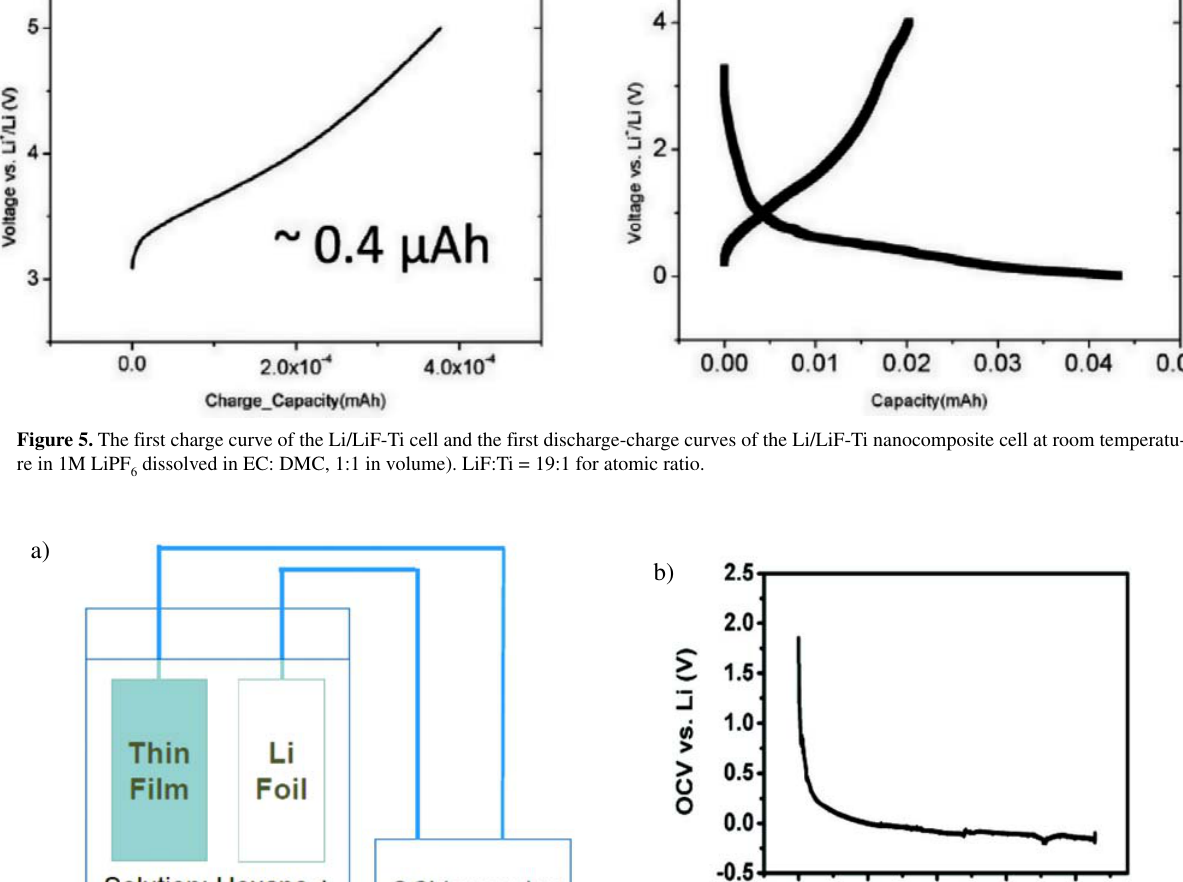
Zheng et al.: Transport of External Lithium Along Phase Boundary ...